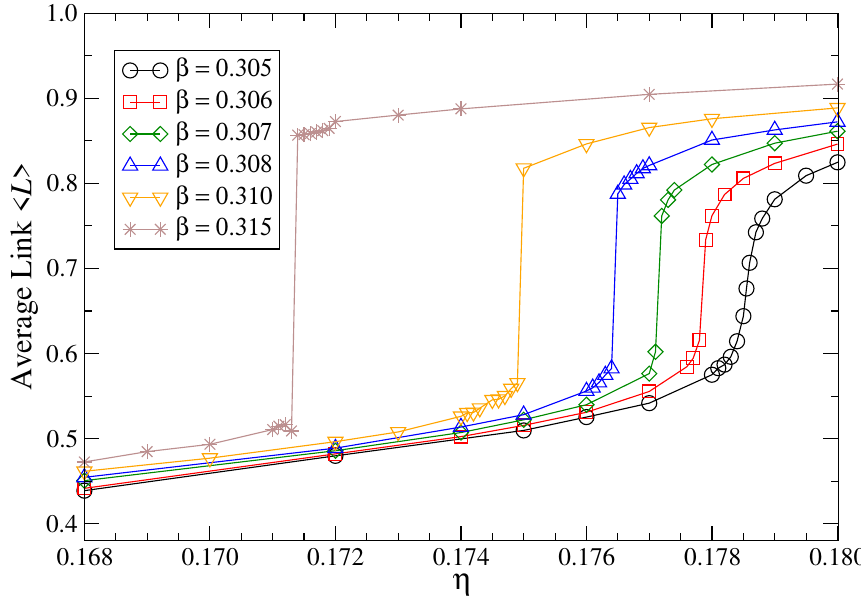
Figure 8 . η dependence of h L i at µ = 0 for β ∈ [0 . 305 , 0 . 315] .